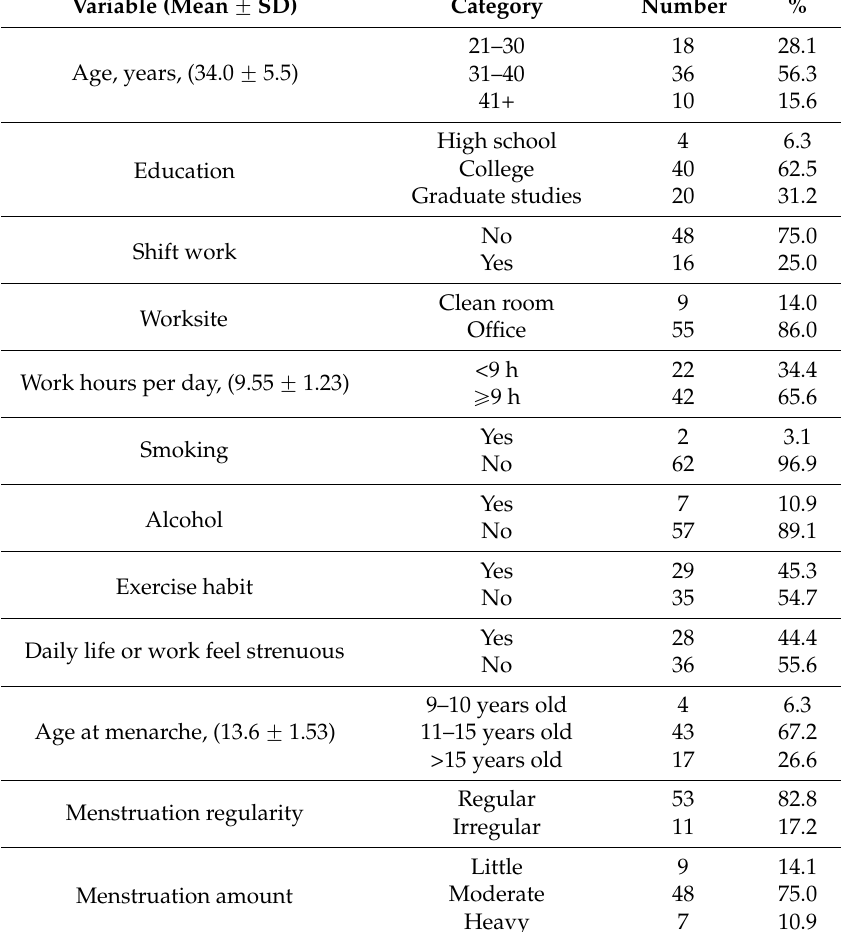
Table 1. Descriptive characteristics of 64 study